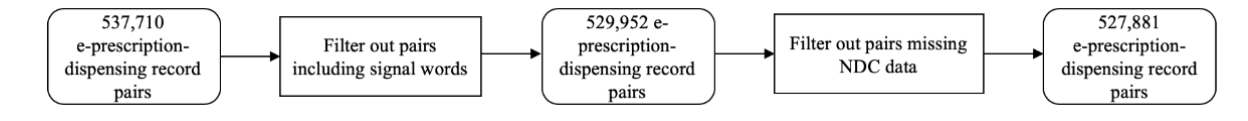
Figure 1. Data cleaning process. e-prescription: electronic prescription; NDC: National Drug Code.